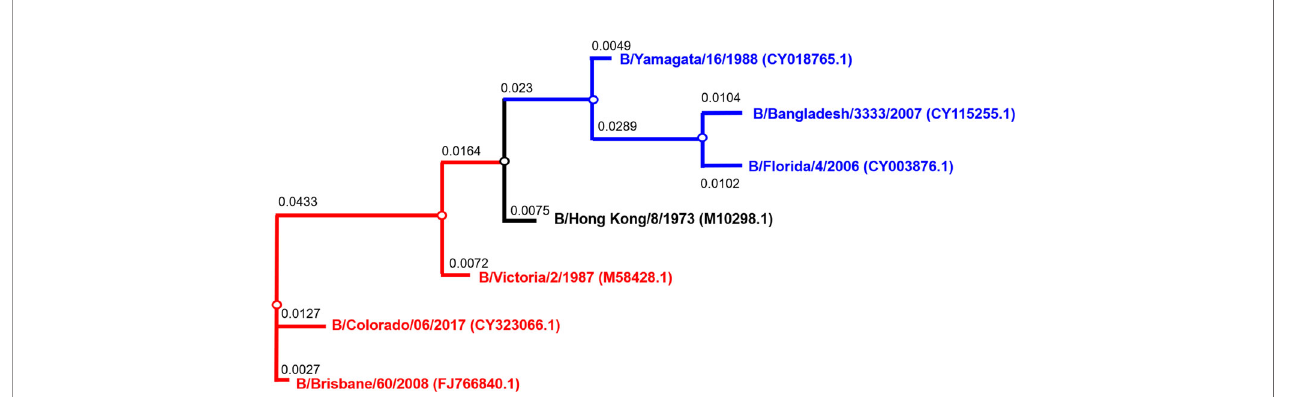
FIGURE 1 | Phylogenetic tree of in fl uenza B HA used for pseudotype production. Phylogenetic tree shows in fl uenza B diverging into two distinct lineages, B/Yamagata (blue) and B/Victoria (red). Accession numbers are reported with the strain name on the tree tips. Nodes are shown at the ends of branches which represent sequences or hypothetical sequences at various points in evolutionary history. Branch lengths indicate the extent of genetic change. The tree generated was constructed with PhyML (48) and graphically elaborated with Archaeopteryx.js